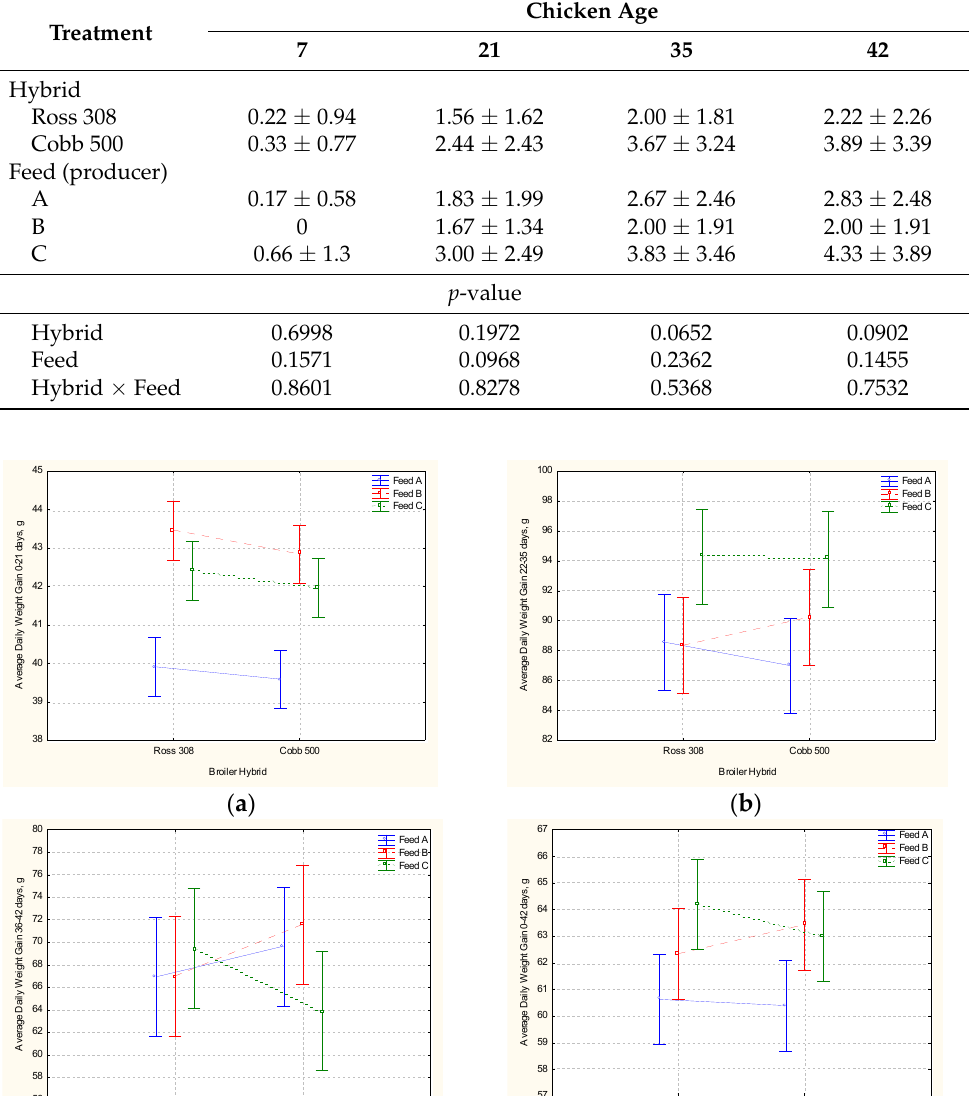
Table 4. Broiler mortality rate during the testing of different hybrids and market feeds. (mean ± standard deviation), %.